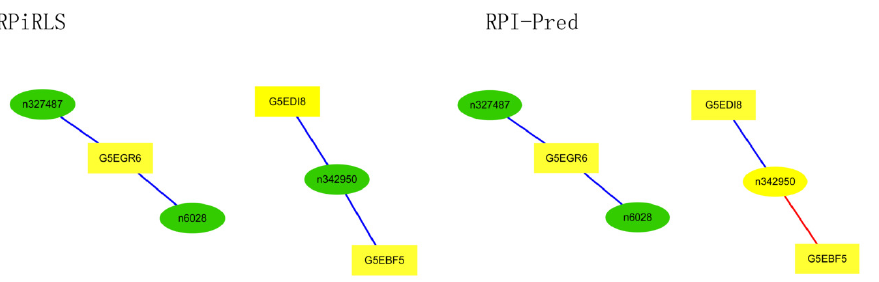
Figure 1. Comparison of the long non-coding RNA-protein interaction networks predicted by the RPiRLS and RPI-Pred methods, for Caenorhabditis elegans. Networks are visualized with Cytoscape v3.4.0. The green (ellipse) and yellow (rectangle) nodes representing lncRNAs and proteins respectively, are connected by edges (solid lines) indicating an interaction between them. The edges colored in blue and red indicate true positive and false negative interactions, respectively.